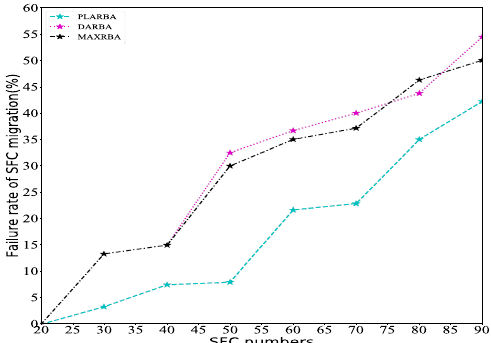
Figure 10. Failure rate of SFC migration with respect to SFC numbers.